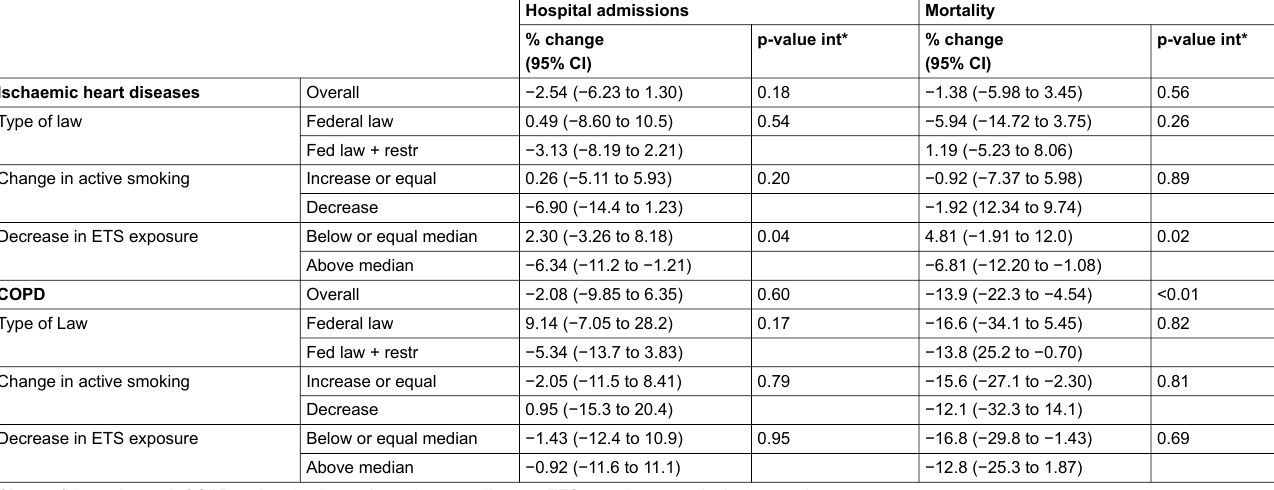
Table S7: Change (and 95% confidence interval) in hospital admissions and mortality due to ischaemic heart diseases and chronic obstructive respiratory diseases in adults (≥35 years old) after the introduction of the smoking ban, by type of law and smoking profile of the canton (adjusted for the socioeconomic and health profile of the population). Results shown in figure 3.